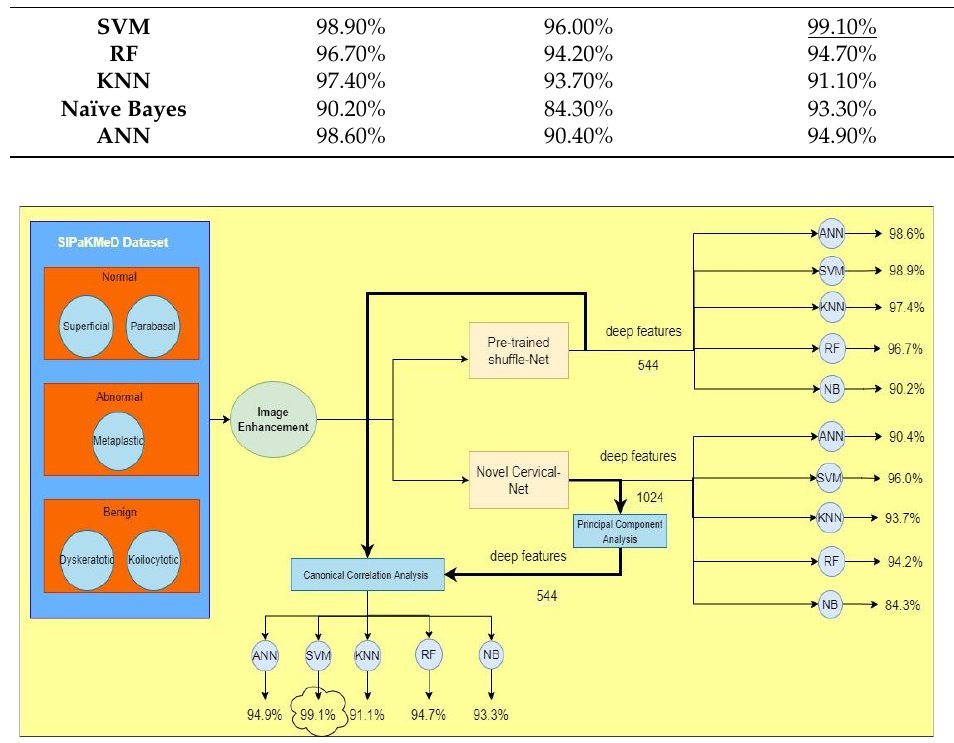
Figure 10. The proposed method with the highest accuracy that has been obtained .